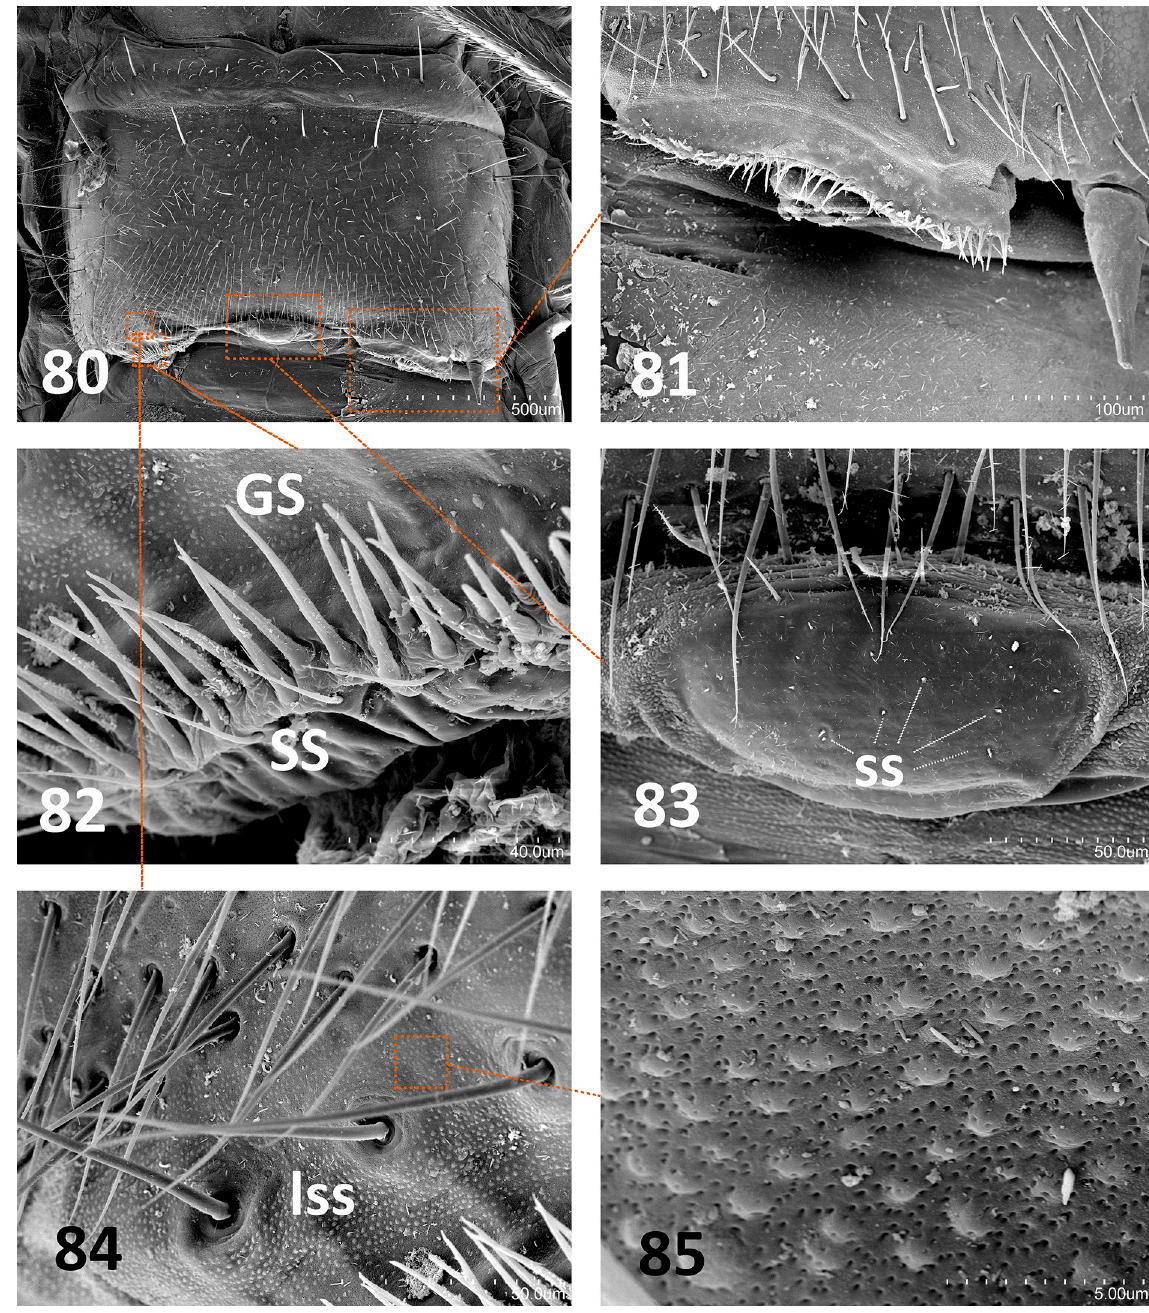
Figs 80‒85. Mueggejapyx brehieri Sendra & Komerički gen. et sp. nov. female. 80 . First urosternite. 81 . Lateral posterior of the first urosternite. 82 . Detail of the lateral coxal organ with glandular setae (GS) and setiform setae (SS). 83 . Median glandular organ (ss: setae-shaped sensilla). 84 . Detail of the large socket setae (lss) of the lateral coxal organ. 85 . Detail of the cuticle of the first